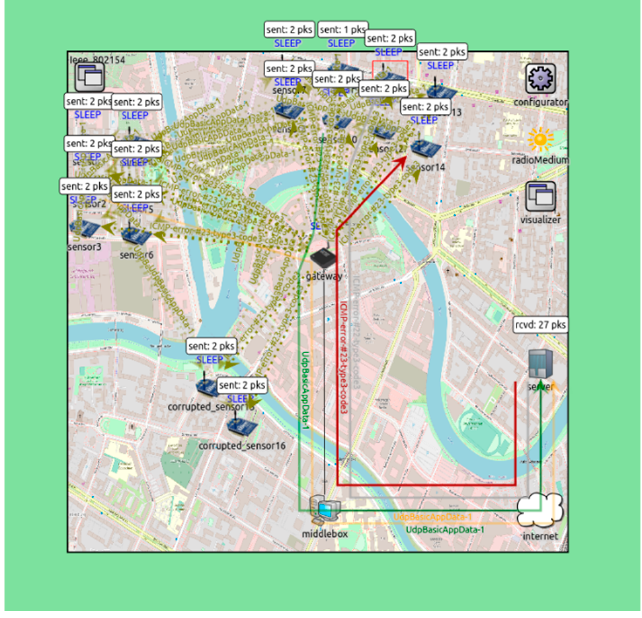
Figure 7. IoT traffic visualization.